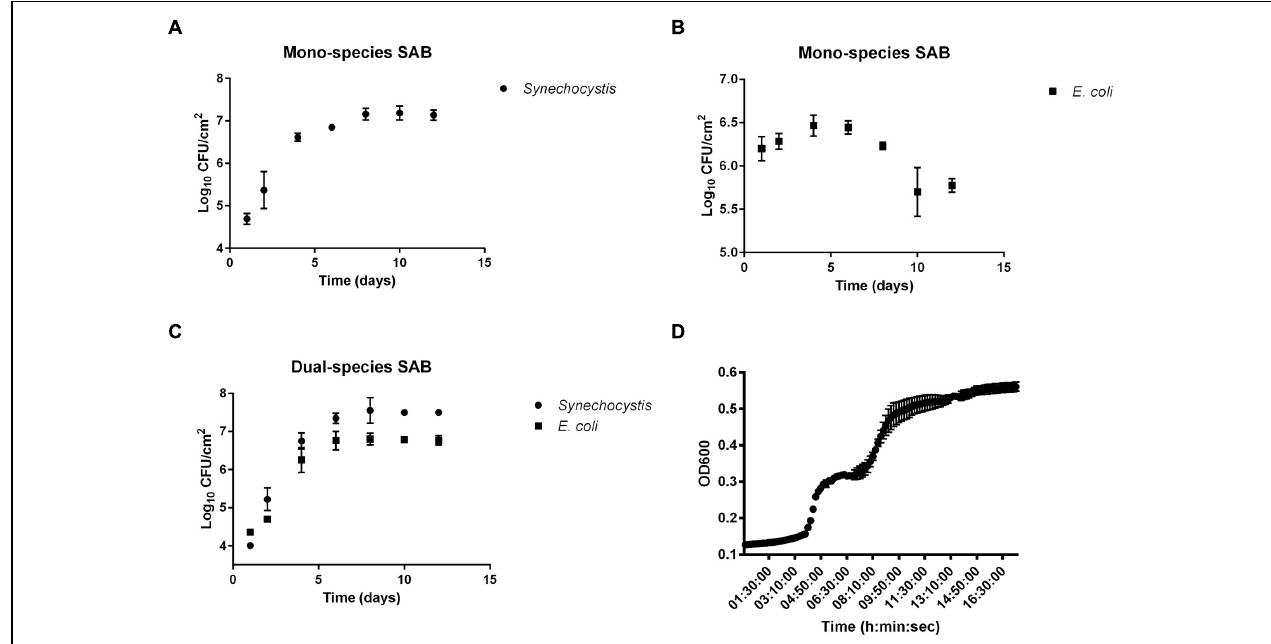
FIGURE 1 | Biofilm growth curves. Biofilm growth of Synechocystis and Escherichia coli in mono ( A,B , respectively) and co-culture (C) . Data points are average of triplicate experiments. Error bars represent standard deviation of experiments. Panel (D) shows the growth of E. coli on cyanobacterial EPS. Data points are average of triplicate experiments. Error bars represent standard deviation of